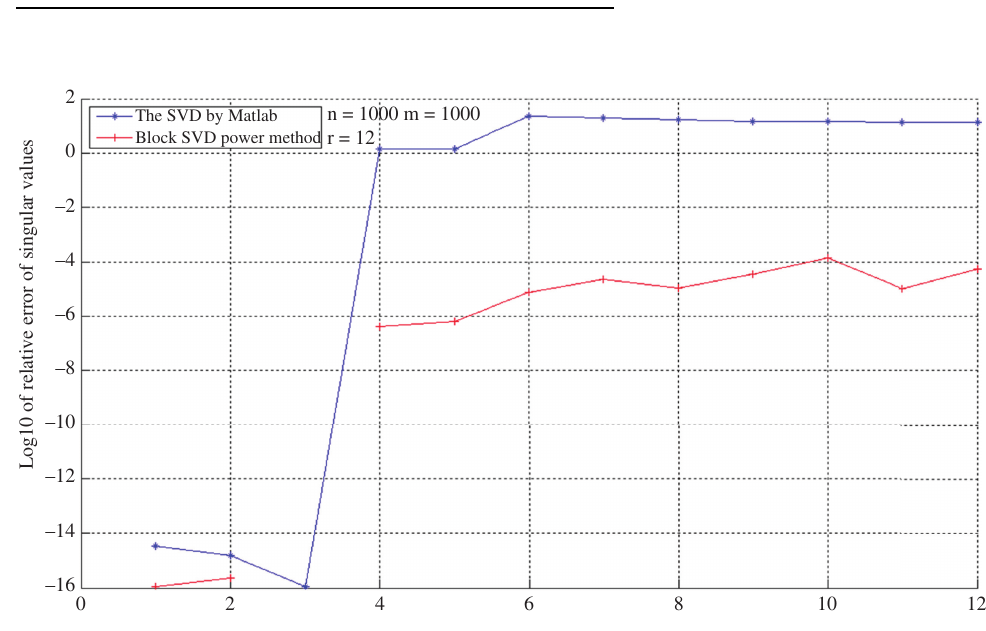
Figure 4: Relative Errors Occurring When Computing the Singular